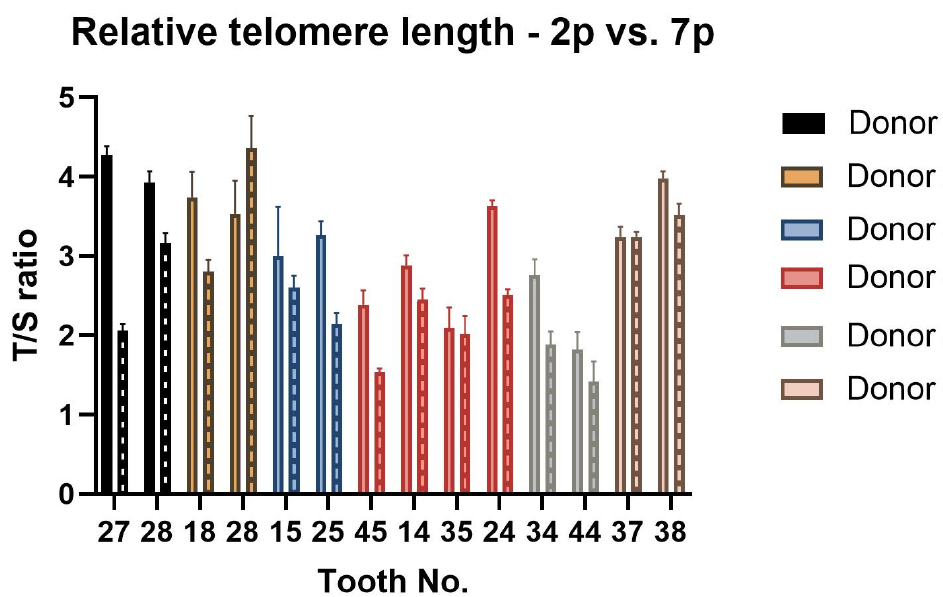
Figure 6. The relative telomere length change measurement between 2nd and 7th passage—T/S ratio. Data are presented as a mean, and SD plotted as error bars. Data for the 7th passage are depicted as boxes filled with patterns. The error bars were calculated for three technical replicates without biological replicates. The statistical significance was calculated using a paired t -test; no comparison was statistically significant. The trend of relative telomere length shortening in the 7th passage measurement was statistically significant compared to the measurement performed in the 2nd passage ( p < 0.05).